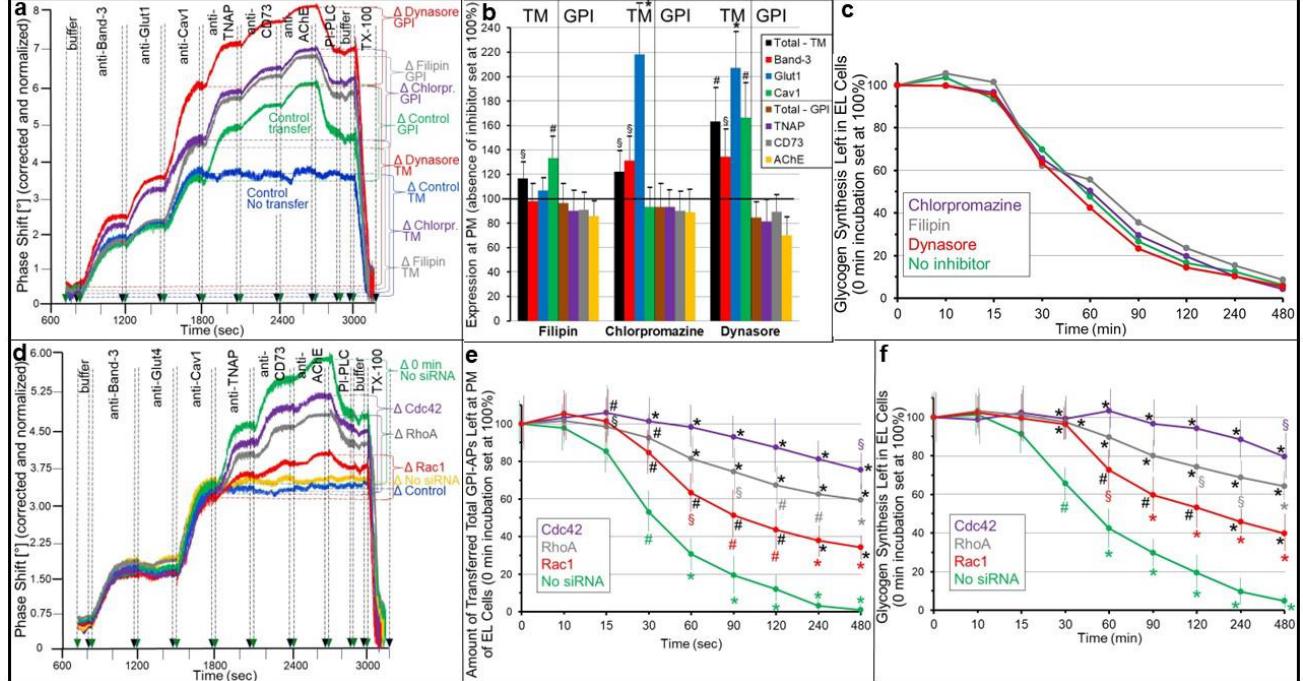
Figure 2. Inhibition of the internalization of transferred GPI-APs via the GEEC and persistence of transfer-induced glycogen synthesis in ELCs. Transwell co-cultures were run with human adipocytes (of lipid-loading stage IV) as donor cells or only medium (Control no transfer) and GPI-deficient ELCs as acceptor cells in the insert and bottom wells, respectively, as described in Section 4. ( a ) After incubation (i) for transfer (1 week, 37 °C, absence of serum and BSA), the insert wells were removed. The bottom wells were rinsed once with medium and then subjected to incubation (ii) with medium for internalization (480 min, 37 °C, absence of serum and BSA) in the absence (Control transfer) or presence of Dynasore (80 µg/mL), filipin (0.5 µg/mL) and chlorpromazine (50 µM). The following procedures were performed as described for Figure 1a. Phase shift Δ was measured in response to the injection of anti-Band-3, Glut1 and Cav1 (800 – 1800 s; TM), as well as TNAP, CD73 and AChE antibodies (1800 – 2700 s; GPI), as summation signals indicated by the horizontal, hatched lines and brackets for each incubation condition. ( b ) The experiment was repeated four and five times (distinct incubations [ii]). Relative amounts of the total (summation signals, black bars) and individual (colored bars) transmembrane proteins (TM) and GPI-APs (GPI) transferred from the human adipocytes during incubation (i) and left at the PMs of the ELCs after incubation (ii) in the presence or absence (set at 100% each) of various inhibitors of endocytosis are given. Significant differences between the absence and presence of each inhibitor for both the total (black bars) and individual (colored symbols) TM and GPI-APs are indicated. ( c ) The acceptor ELCs in the bottom wells of the transwell co-cultures were used for the determination of glycogen synthesis during incubation (iii) for glycogen synthesis (15 min, 37 °C, presence of BSA) with [U- 14 C]glucose (0.1 mM) after the various periods of incubation (ii) in the absence (green line) or presence of the various inhibitors, as described in Section 4. Relative glycogen synthesis left in ELCs is given, with no incubation (ii) (0 min) set at 100%. ( d ) Transwell co-cultures were run with human adipocytes as donor cells or only medium (Control) and ELCs as acceptor cells in the insert and bottom wells, respectively, as described in Section 4. After incubation (i) for transfer (1 week, 37 °C, absence of serum and BSA), the insert wells were removed. The bottom wells were rinsed once with medium and then subjected to incubation (ii) with medium for internalization (37 °C, absence of serum and BSA) in the absence of siRNA for 0 min (No siRNA; green curve) and 480 min (No siRNA; orange curve) or presence of siRNAs (30 nM) directed against Cdc42, RhoA and Rac1 for 480 min. The following procedures were performed as described for Figure 2a, except for injecting anti-Glut4 rather than Glut1 antibodies. ( e ) The experiment was repeated four to seven times (distinct incubations [ii]). Relative amounts of the total GPI-APs (summation signals) transferred from the human adipocytes during incubation (i) and then left at the PMs of ELCs after incubation (ii) in the presence or absence of siRNAs are given, with the 0 min incubations set at 100% each. Significant differences between each incubation period and the 0 min incubation (colored symbols), as well as between the absence